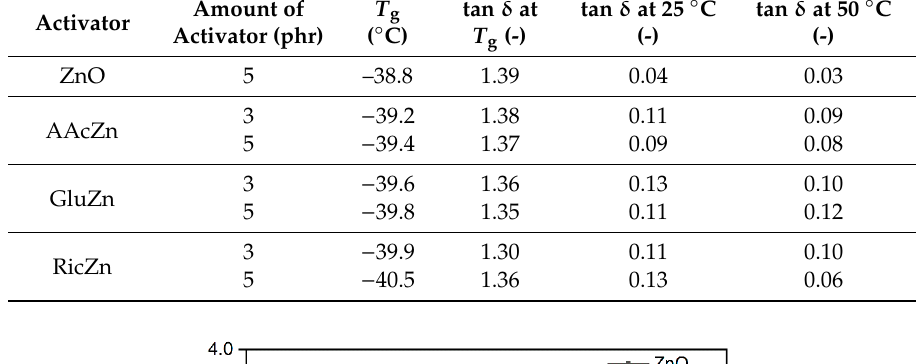
Table 6. Glass transition temperature ( T g ) and loss factor (tan δ ) of SBR vulcanizates (standard deviations: T g ± 0.5 ◦ C, tan δ ± 0.06).